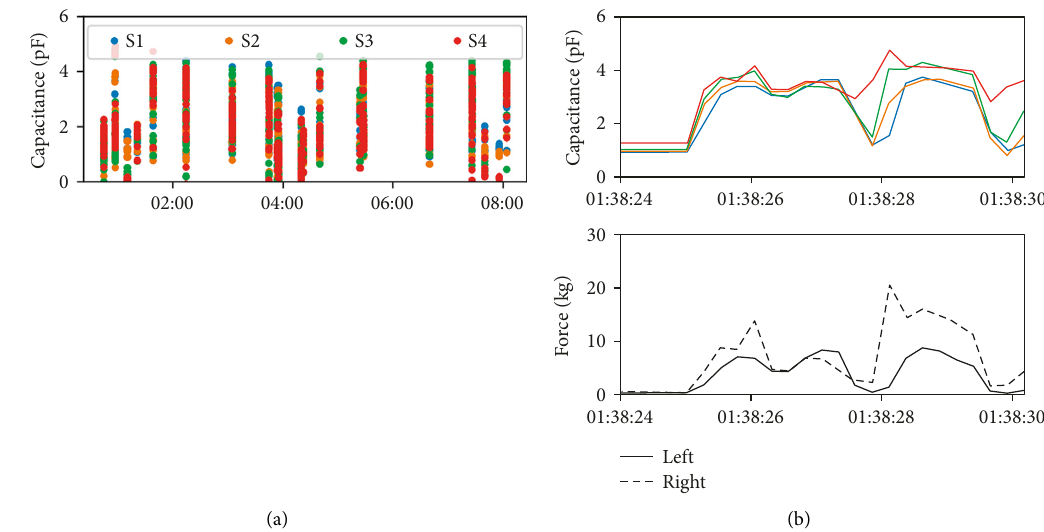
Figure 3: (a) Overview of the whole night of recording, in which the 4-coloured dots represent the signal from each of the 4 sensors in the bite. (b) Example of one of the detected episodes, which shows the dynamics of the bruxism episode and the occlusion forces calculated for the left and right parts of the jaw.